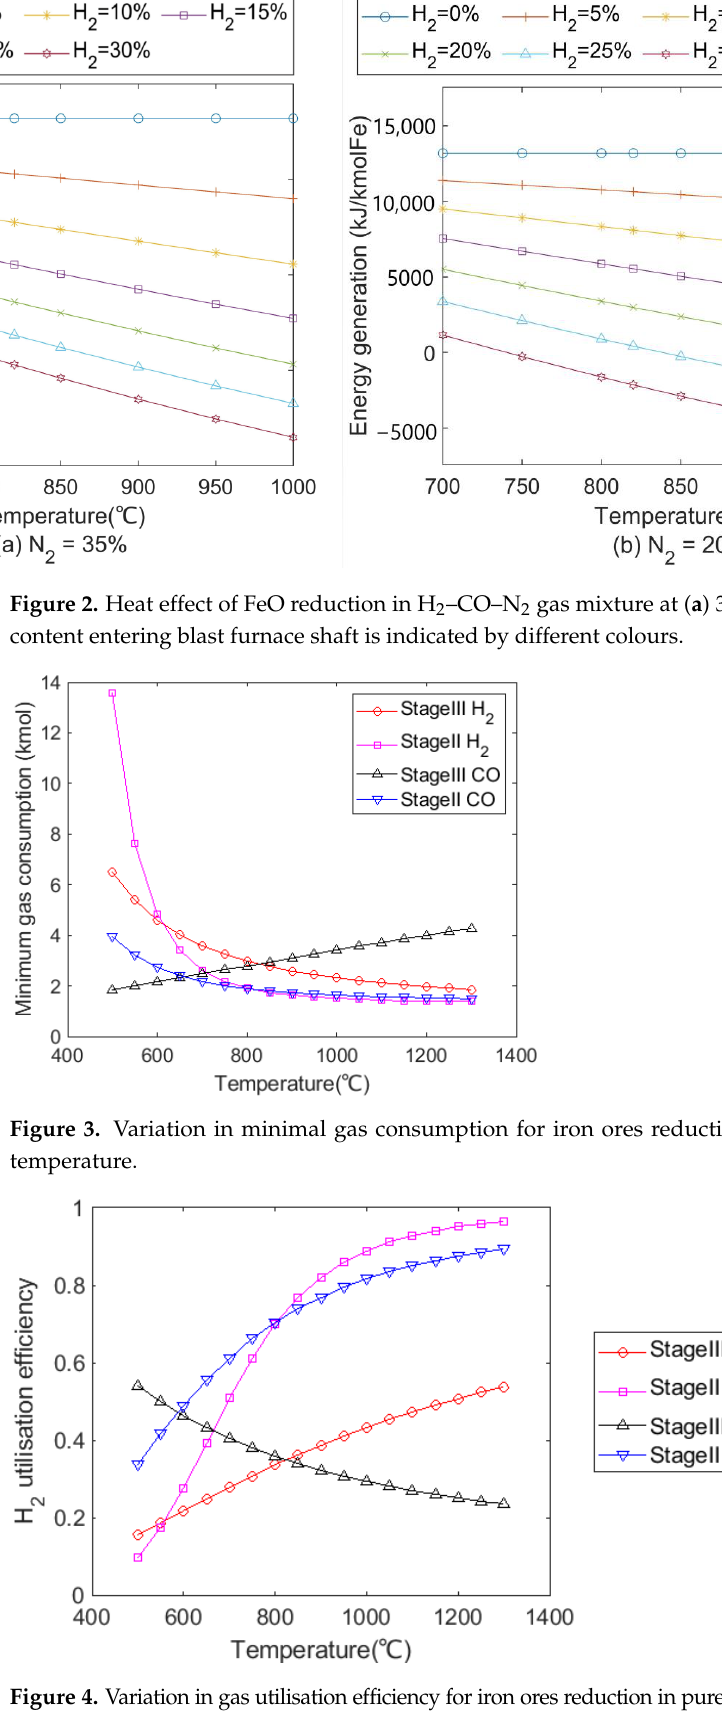
Figure 4. Variation in gas utilisation efficiency for iron ores reduction in pure H 2 or CO with tem- perature. On the basis of the calculation from Equation (41), gas utilisation efficiency at dif- ferent H 2 contents in the reducing gas for FeO and Fe 3 O 4 reduction is shown in Figure 5.